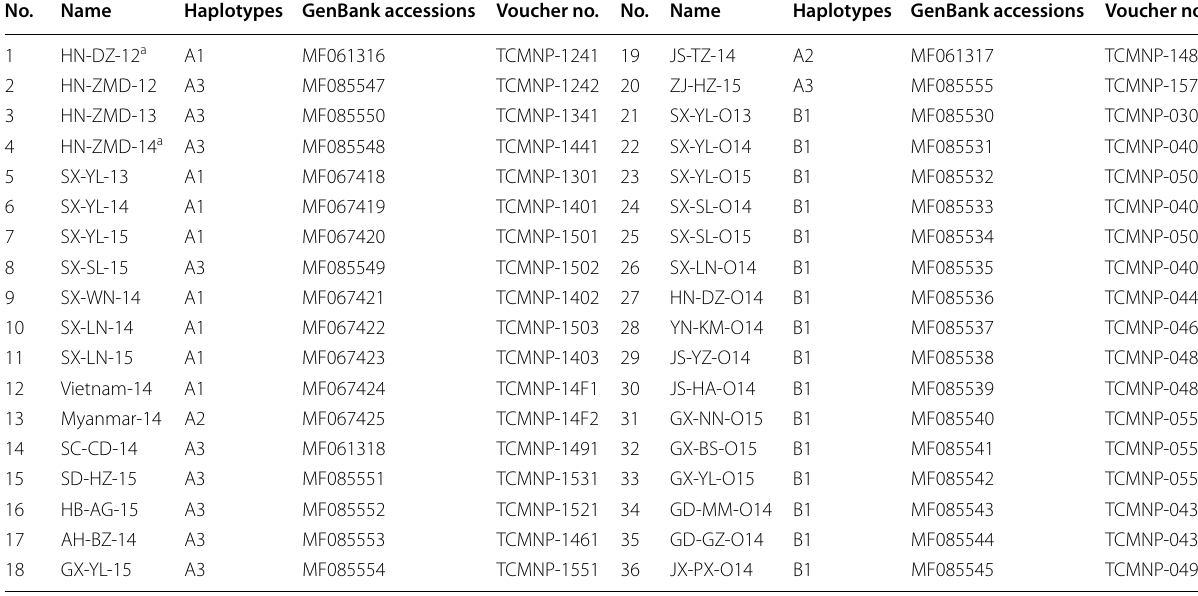
HN-ZMD-14 indicated that the sample was collected from Zhumadian city, Henan province in 2014 a Indicated these samples were collected from wild field and the other samples were collected from the cultivars fields or experimental fields